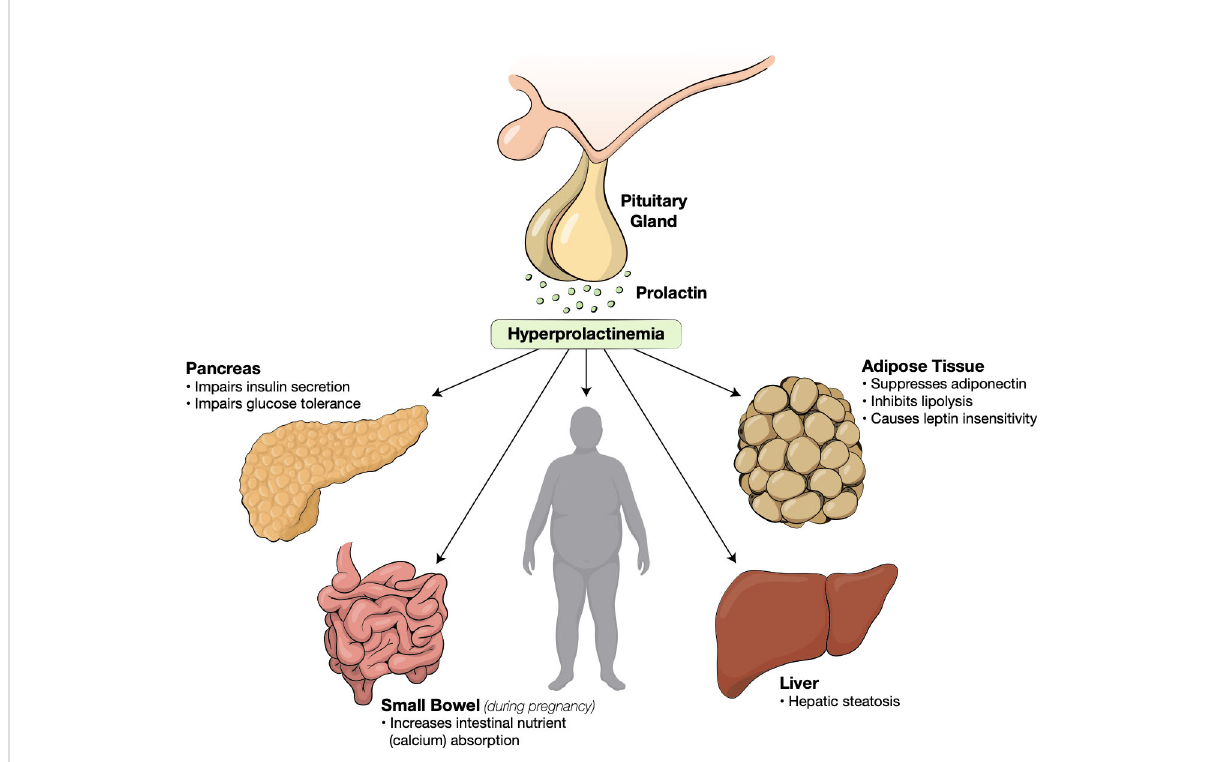
FIGURE 1 Metabolic effects of